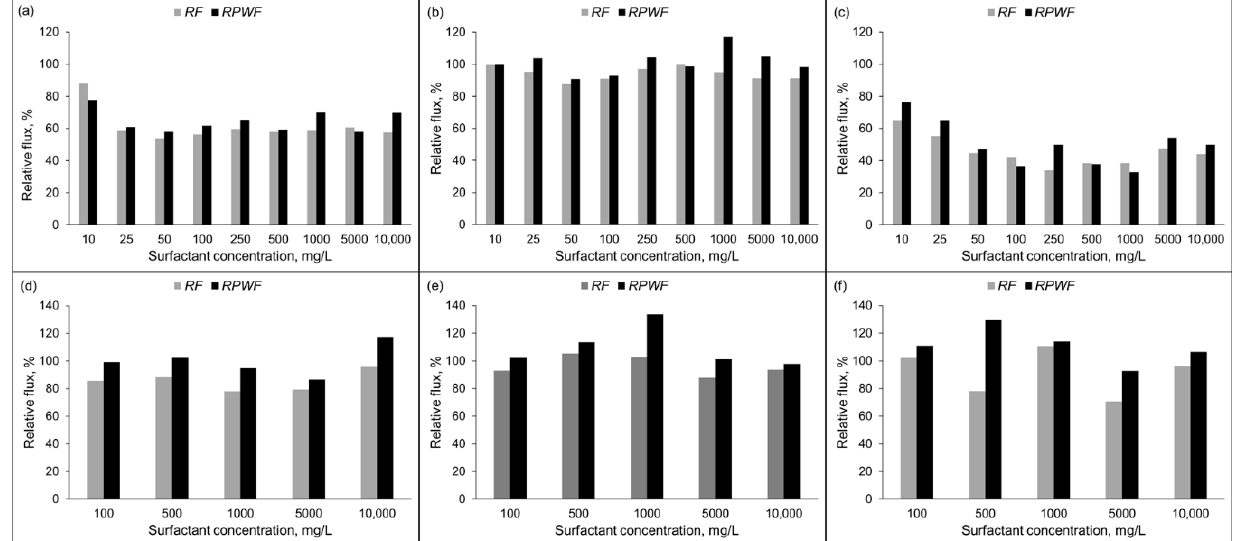
Figure 5. Relative flux ( RF ) and Relative pure flux (RPWF) of RO membrane; PA membrane: ( a ) Tw 20; ( b ) SO; and ( c ) CTAB and CA membrane: ( d ) Tw 20; ( e ) SO; and ( f ) CTAB (10% recovery ratio, TMP = 1.5 MPa, T = 25 °C).